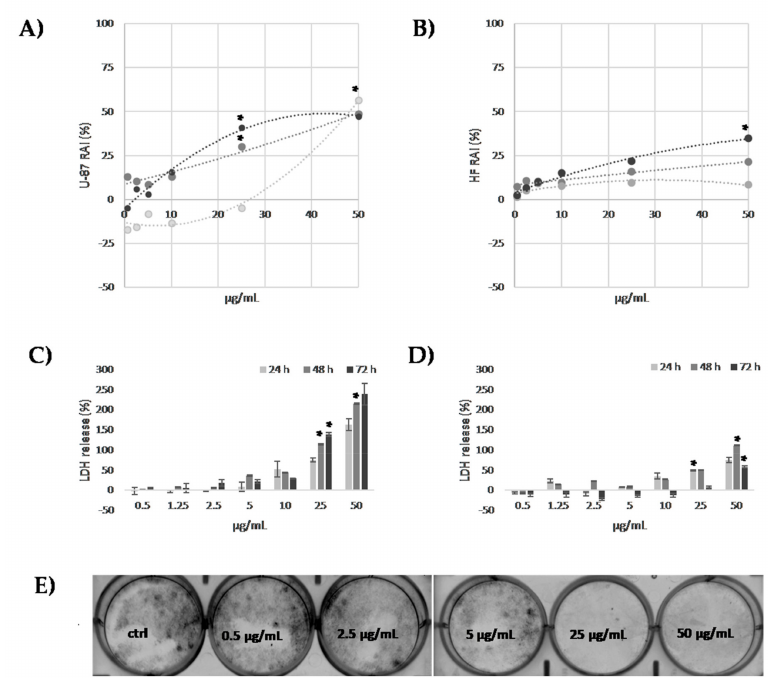
Figure 6. Cell viability of U-87 and human HF cell ( A and B , respectively) was assessed by MTT assay after 24, 48 and 72 h of exposure. Data from LDH release assay at 24, 48 and 72 h exposure times were in panels C (U-87 cells) and D (HF cells). Values are the mean ± SE of two independent experiments performed in triplicate. * p < 0.05 vs. untreated cells. ( E ) Representative images from colony forming e ffi ciency of U-87 cells grown in presence of LnHS or vehicle control for ten days; the experiment was performed in duplicate.